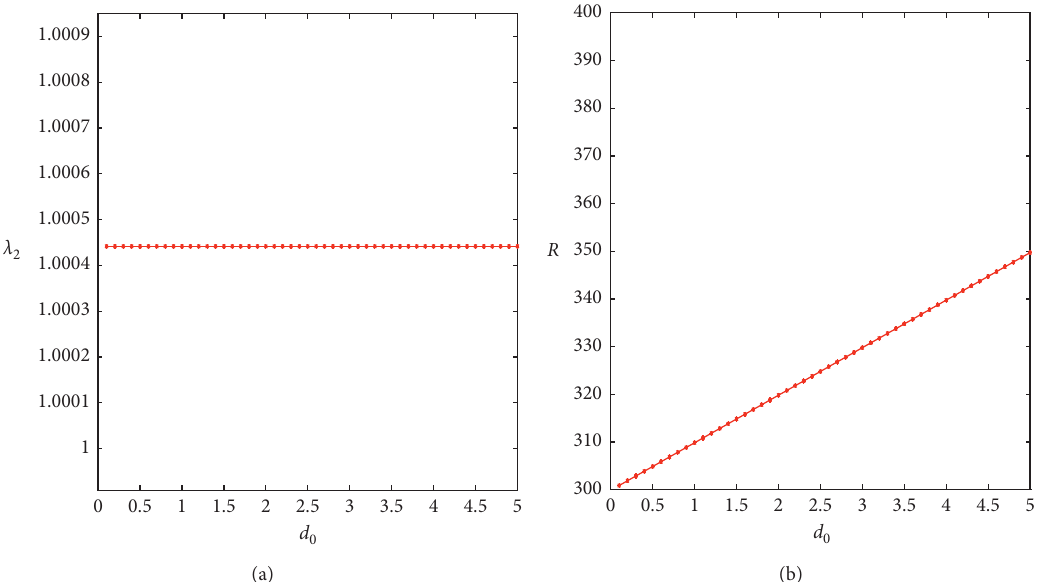
Figure 13: The synchronizability of multilayer star-ring networks vs . varying the interlayer coupling strength d 1, and a < Md ). (a) λ 2 with respect to varying d 0 . (b) R with respect to varying d 0